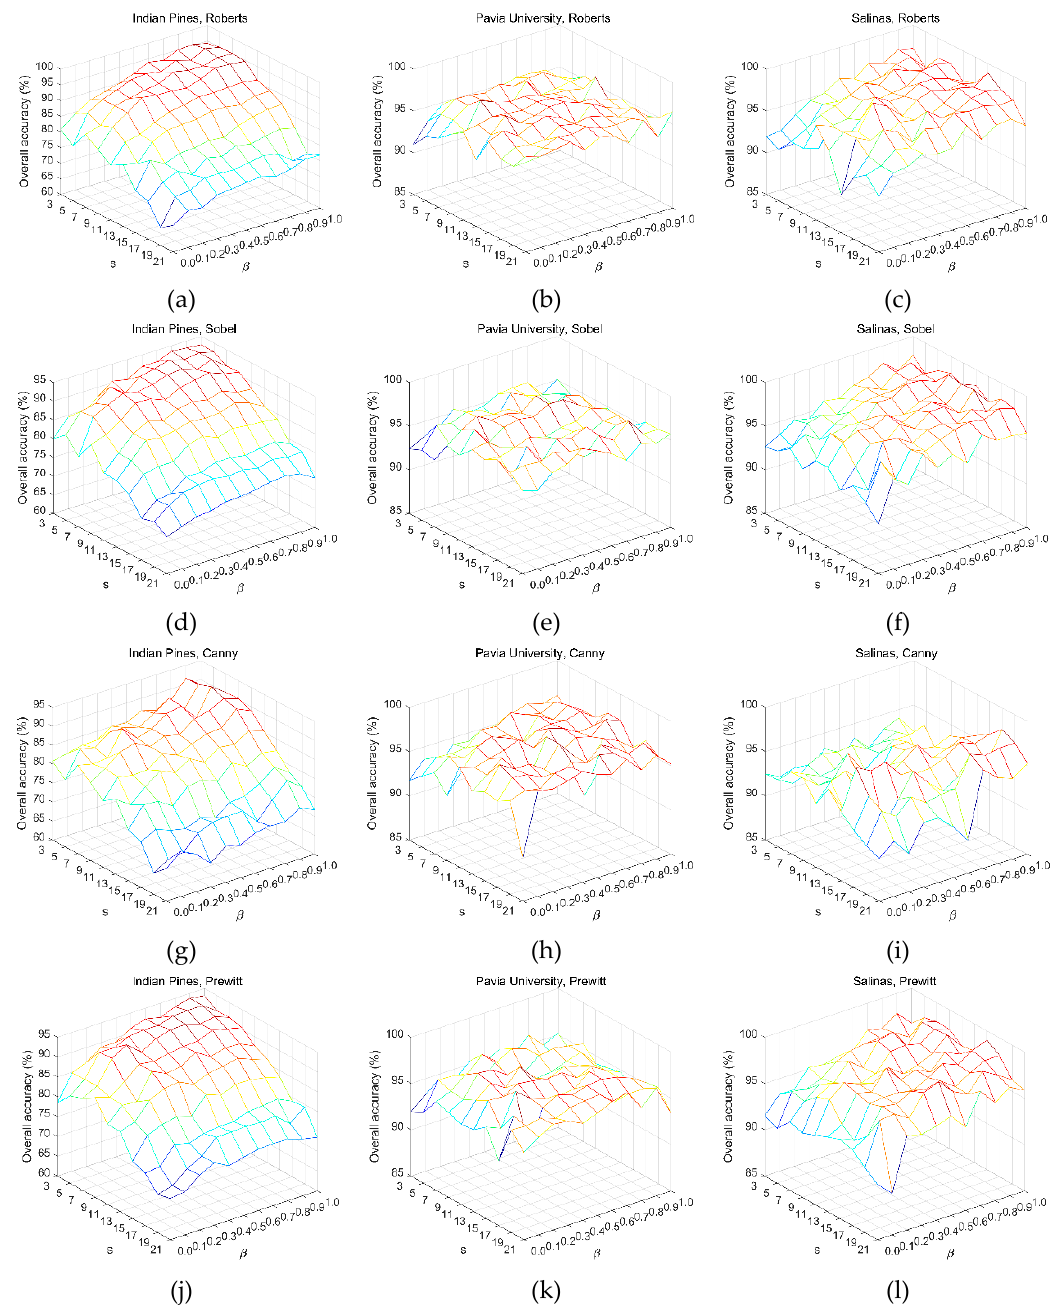
Figure 9. The classification results of four edge detection operator Robert, Sobel, Canny and Prewitt for different parameter combinations on three hyperspectral datasets. (Note: The color of the line represents the size of the OA accuracy. From dark blue to deep red, it means that the OA accuracy changes from small to greater. It can be clearly seen from (a)).